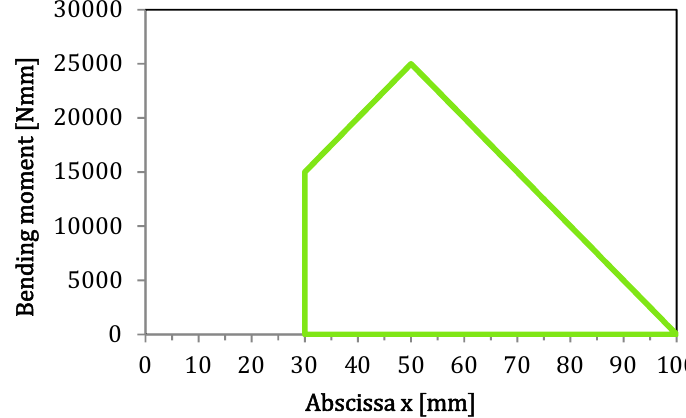
Figure 2. Bending moment diagram in the 3rd and 4th region of the AENF specimen.